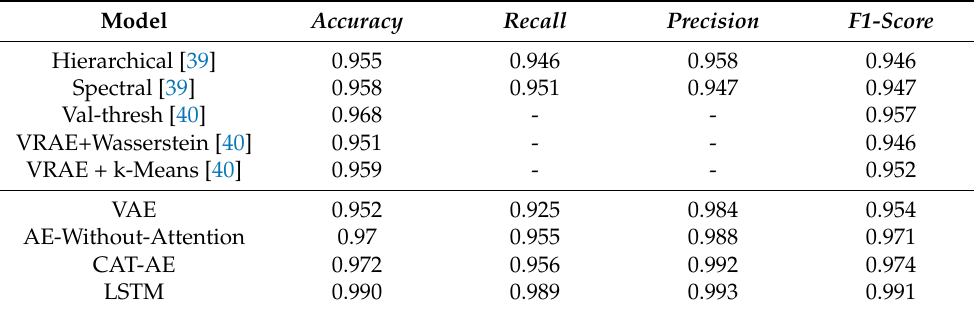
Table 1. Comparison of results performance on the ECG5000 test